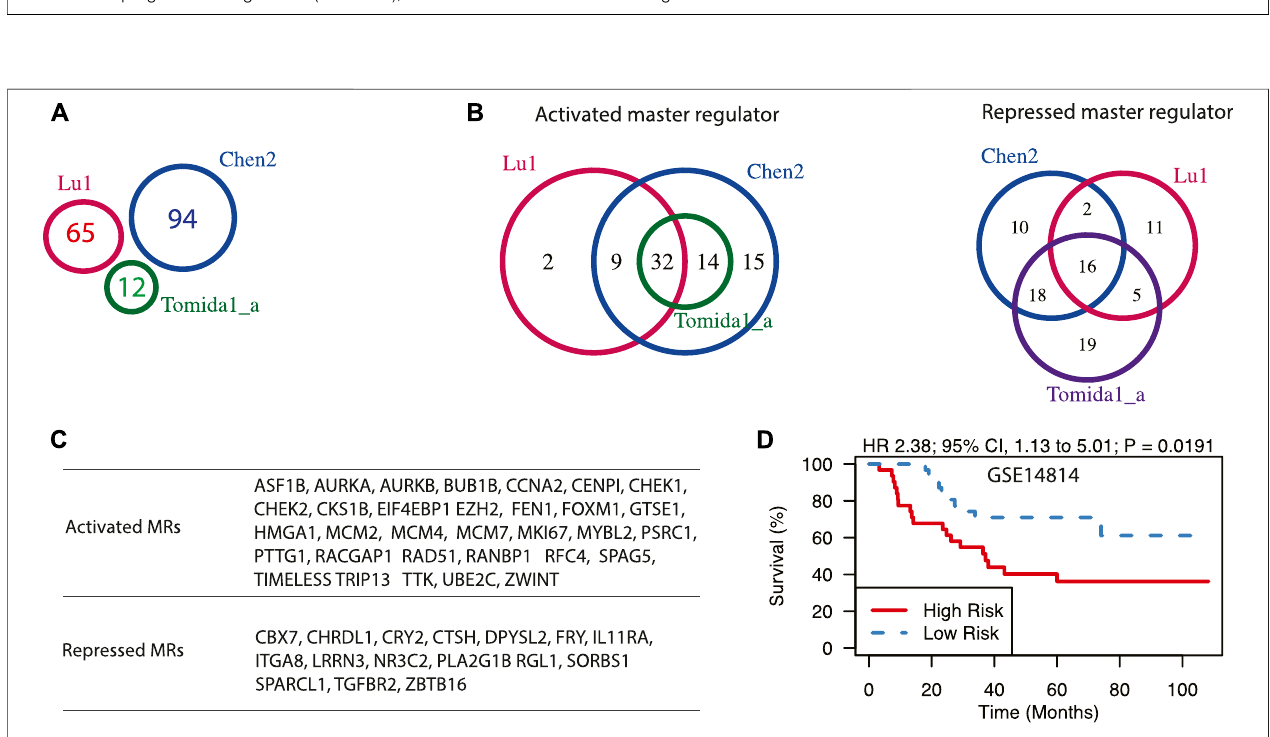
FIGURE3| Masterregulatorsdrivingprognosisinearly-stageLUAD. (A) AVenndiagramofthreeprognostic signaturesforearly-stage LUAD.Signaturenamesas well as the number of genes in each signature were shown. (B) The Venn diagram of activated and repressed master regulators, predicted from three prognostic signatures for early-stage LUAD. (C) The lists of shared master regulators that are predicted from all three signatures. (D) Expression of shared master regulators is associated with poor survival in patients with stage I LUAD in dataset GSE14814. Hazard ratio (HR) and log-rank test p -value are also shown.